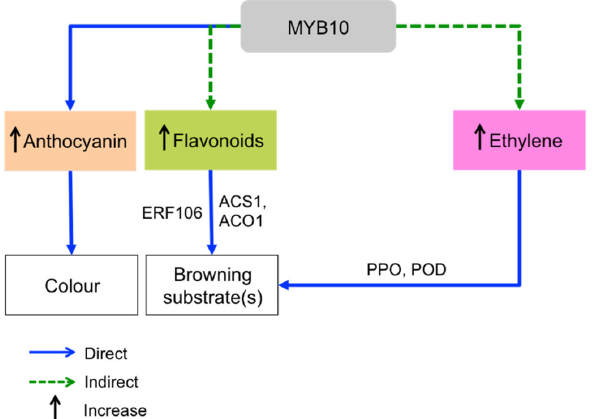
Figure 7. A proposed schematic model to elucidate the link between increased anthocyanin level and internal browning-flesh disease activation. The expression of MYB10 TF directly increases anthocyanin levels by activating the anthocyanin biosynthesis pathway, which indirectly induces flavonoid production by enhancing pathway flux. Furthermore, MYB10 is also associated with early activation of ethylene production possibly via interaction with ERF106. Early activation of ethylene production leads to an increase in transcription and enzyme activity caused by PPO. These events consequently promote early ripening, production of POD enzyme and accumulation of additional substrate(s) which caused browning.